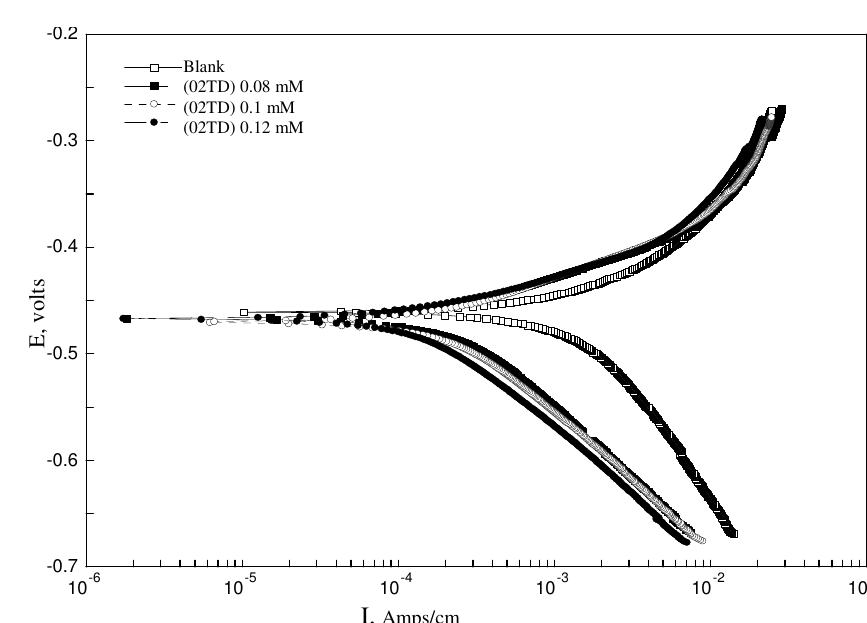
SO in absence and 2 4